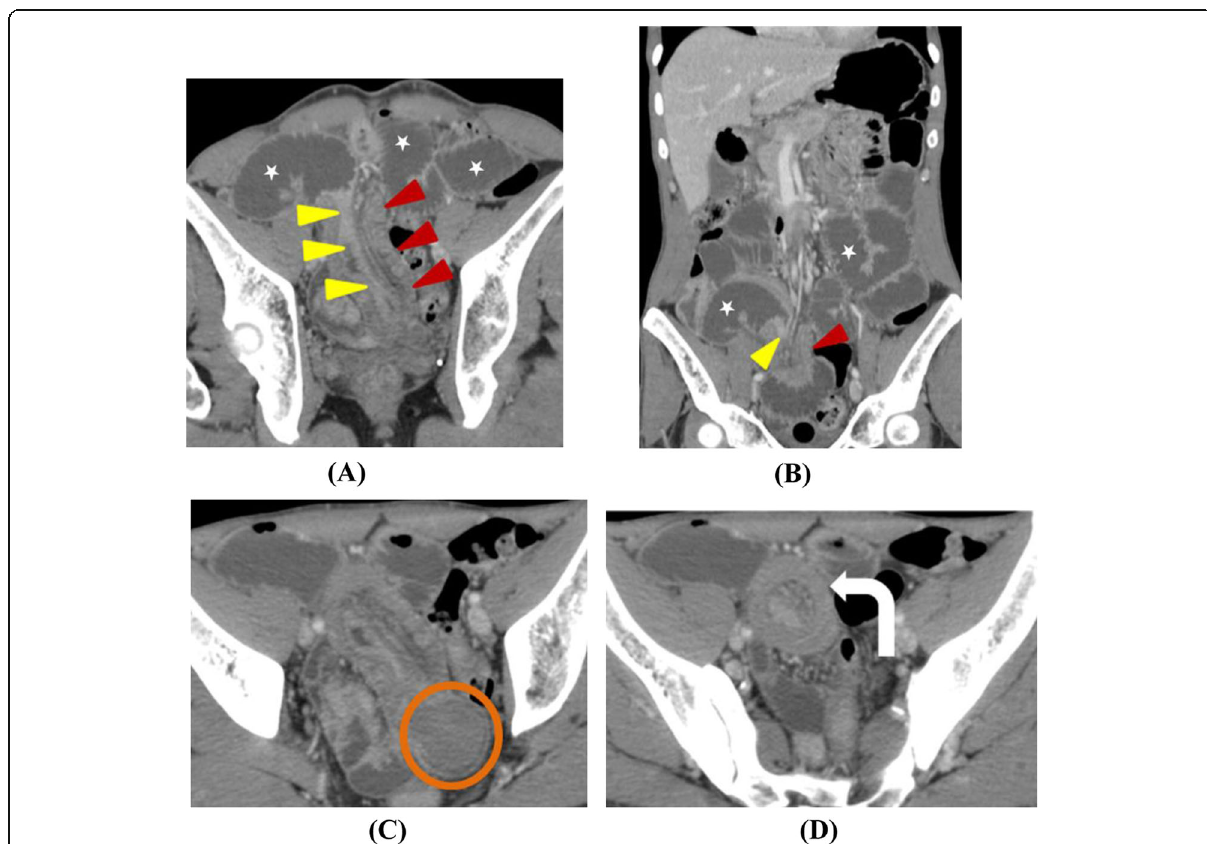
Fig. 6 Entero-enteric intussusception in a 65-year-old male presented with acute abdominal pain and vomiting. Axial CT image ( a ) and coronal CT image ( b ) showing invagination of distal jejunal bowel loops (the intussuceptum) (yellow arrowheads) into proximal ileal bowel loops (the intussuscipient) (red arrowheads) with subsequent dilated proximal small bowel loops (stars). c Axial CT image showing the lead point for this intussusception; intra-mural soft tissue mass lesion (circle). Sausage shape appearance is seen in axial CT images ( a & c ) . d Axial CT image at another level showing the typical target sign (curved